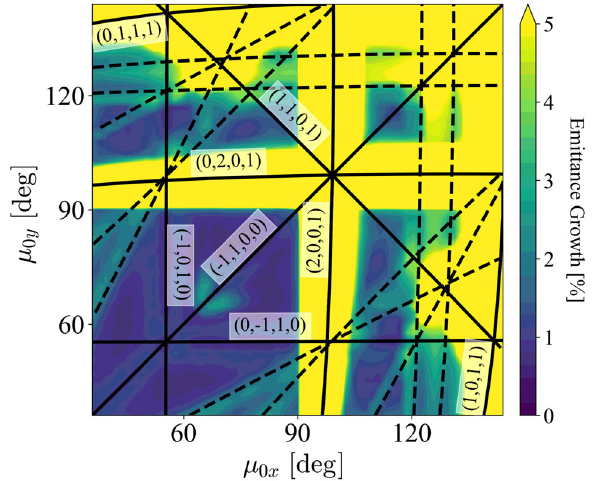
FIG. 15. W ARP simulation results with the bare synchrotron tune σ 0 k fixed at 55°. The initial phase-space distribution of particles in the bunch is the Gaussian type. The projected rms emittances in the three spatial directions are equalized every- where in the diagram. The beam intensity is maintained at the value that gives η ⊥ ¼ 0 . 8 at the operating point ð μ 0 ⊥ ; σ 0 k Þ ¼ ð 60 ° ; 60 ° Þ . Solid and dashed lines in the picture indicate the locations of the possible second-order and third-order stop bands obtained from Eq. (B1) with C 2 ¼ 0 . 7 and C 3 ¼ 0 . 8 . Four ; n ; n k ; n 0 Þ integers written beside each line represent ð n x y